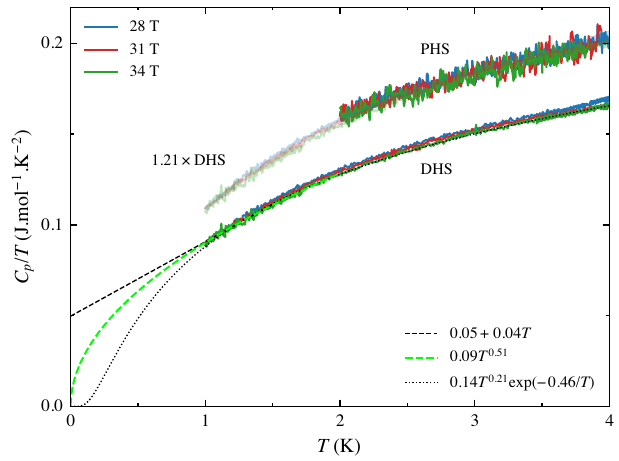
FIG. 1. Temperature scans obtained at 28, 31, and 34 T for temperatures T ≤ 4 K for the PHS and DHS single crystals. The phononic and Schottky-type contributions are negligible in the considered temperature and field ranges. Hence, the kagome contribution is directly measured and found to be field indepen- dent. The PHS and DHS data are found to scale by a factor 1.21; see the transparent lines. The dashed lines indicate possible extrapolations to zero temperature, as detailed in the text. below 4 K for fields B ≥ 28 T. On the T ≤ 4 K range and in these high fields, C kago p is found to be field independent in both samples.